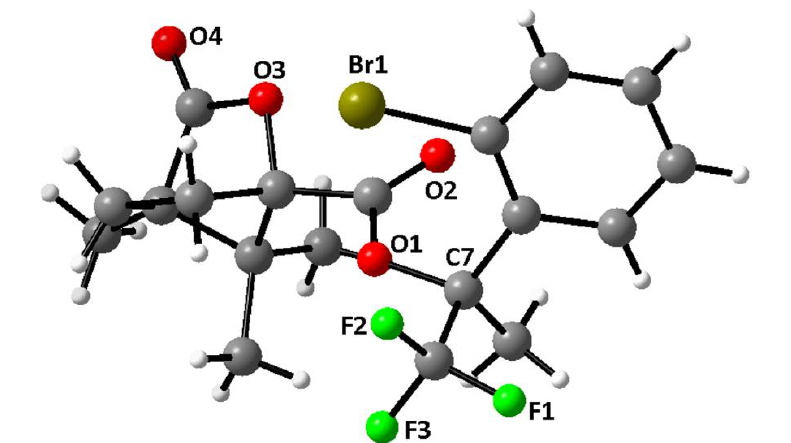
Figure 1. X-ray crystal structure of ( S )-c .